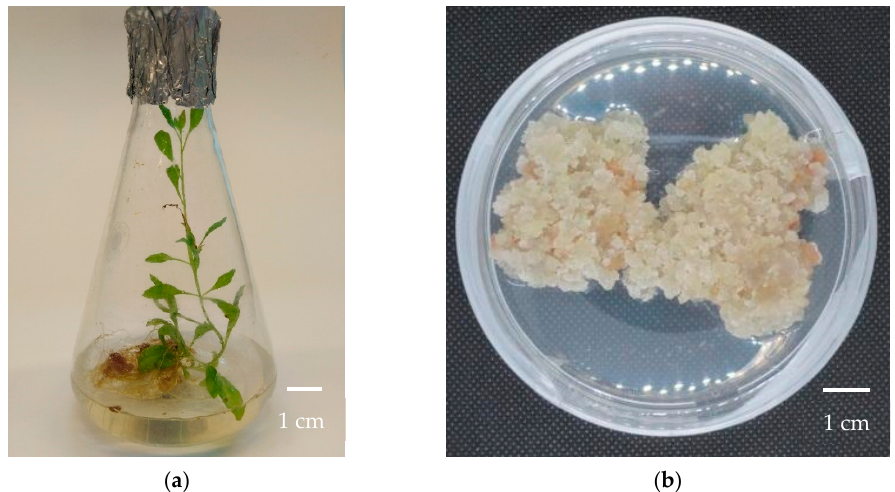
Figure 1. Callus induction of L. schweinfurthii . ( a ) Sterilized plants after 3 weeks of aseptic seeds germination; ( b ) Callus induced on MS medium fortified with 2 mg L − 1 NAA after 5 weeks of cul- turing.